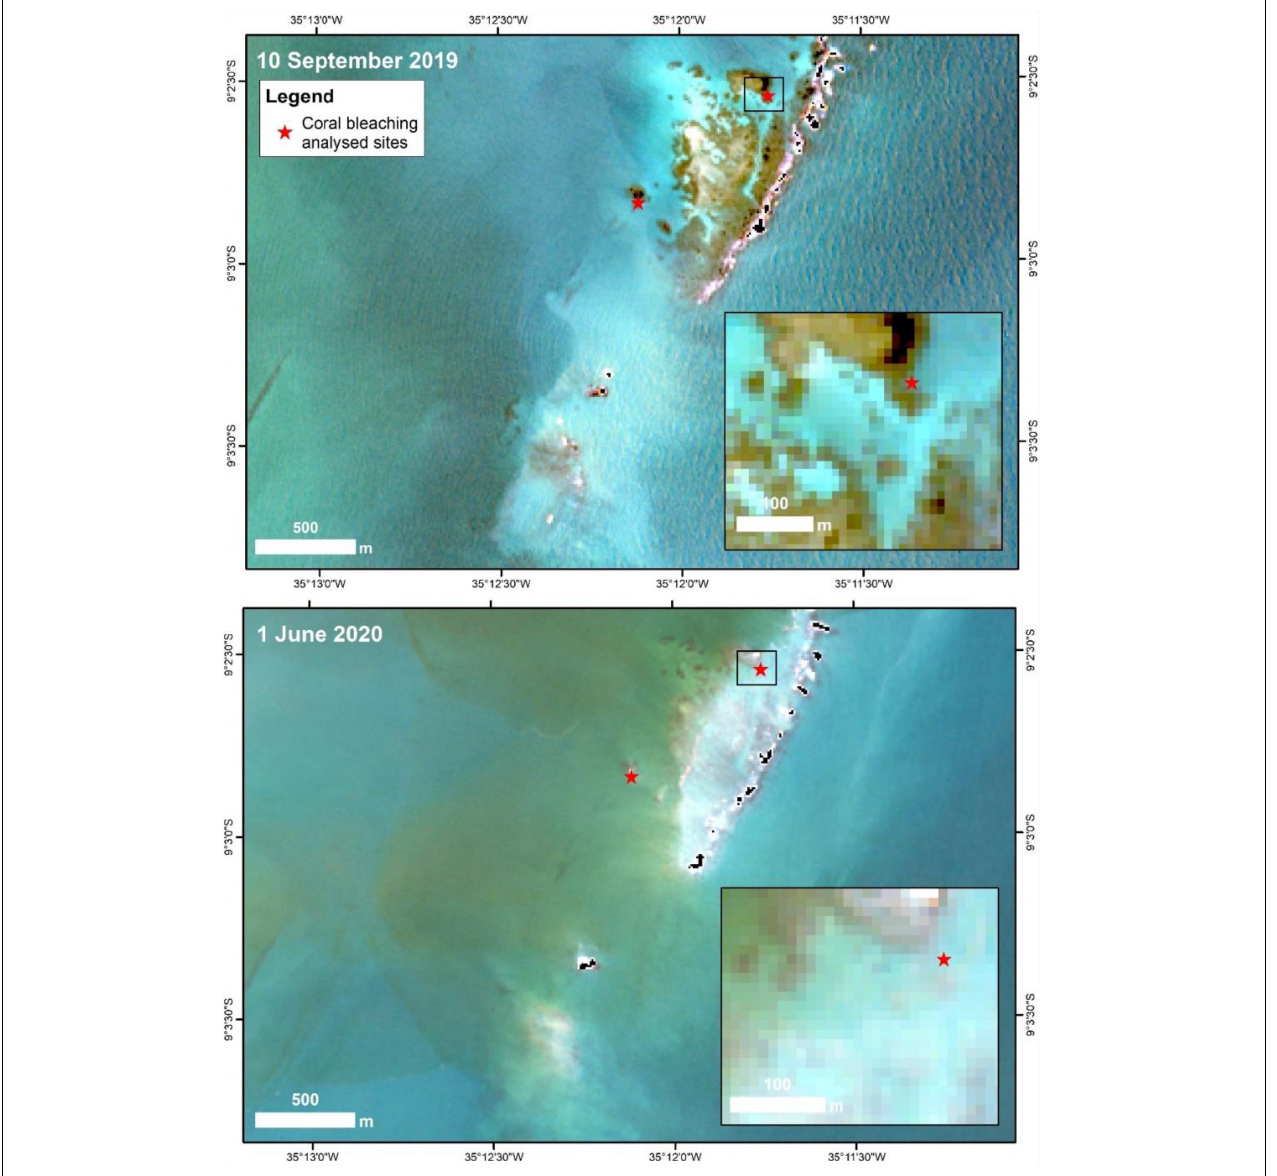
FIGURE 4 | Visible bleaching on Sentinel-2A images at the Aquario reef in June 2020, compared to September 2019. The two smaller images are those which reflectance was compared and show a zoomed area as represented by a black rectangle in the upper left panel.